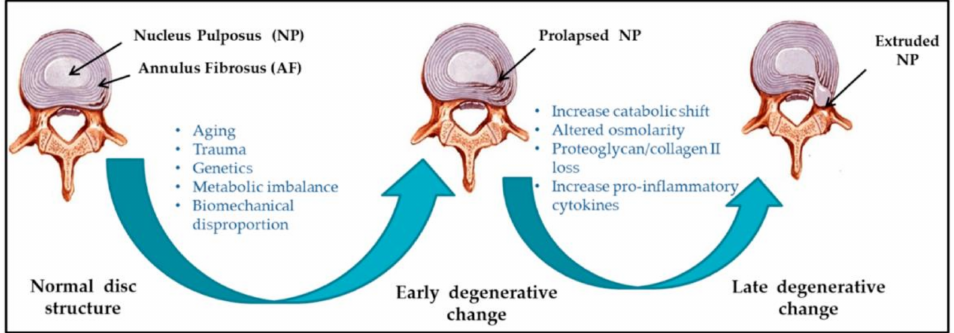
Figure 1. Schematic representation of intervertebral disc (IVD) pathophysiology during degeneration. Reprinted from an open access source